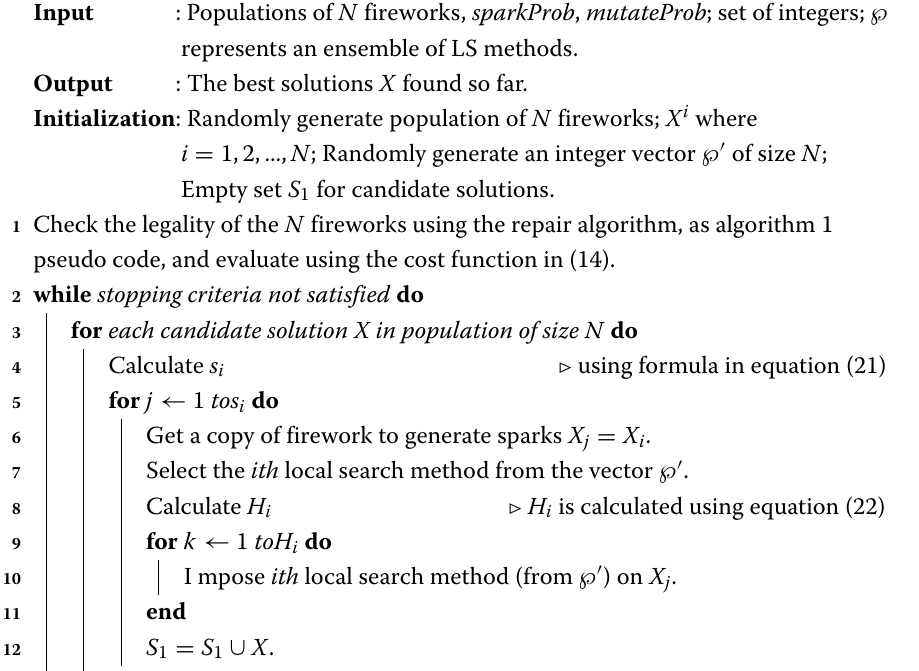
Algorithm 2: DFWA-with-Dy-3-LS pseudo code for the